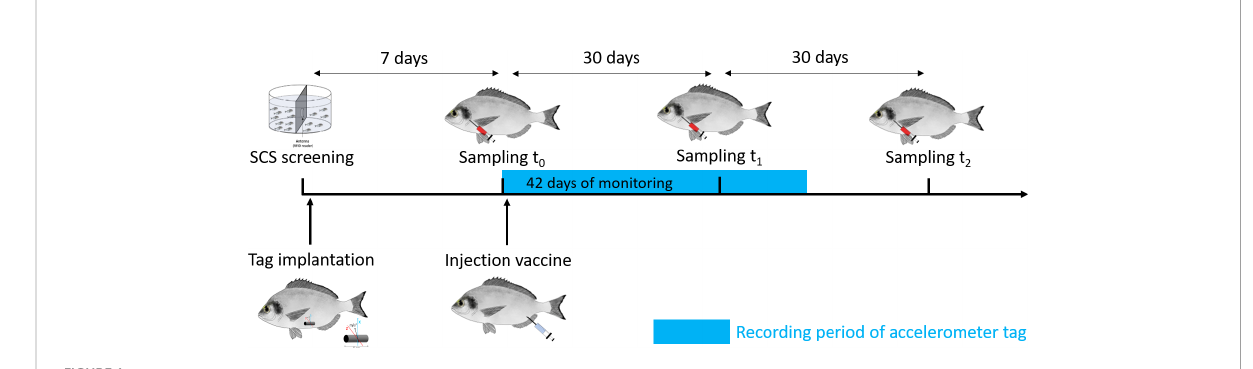
FIGURE 1 Timeline of the experimental protocol performed. SCS, stress coping